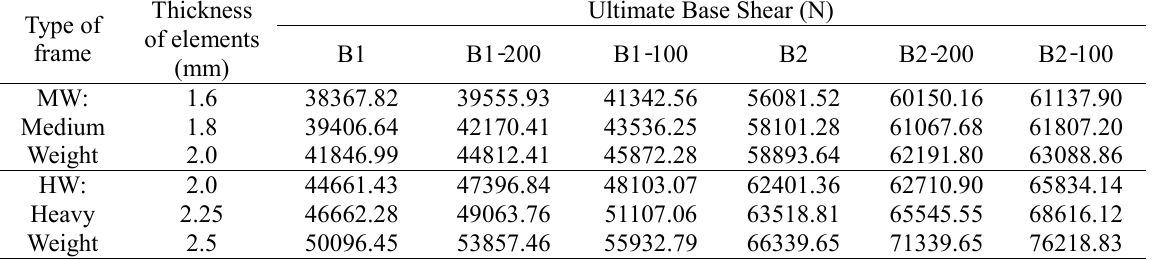
Variation of ultimate base shear of B1 and B2 type frames with respect to section thickness and use of spacer bars (as per UBC